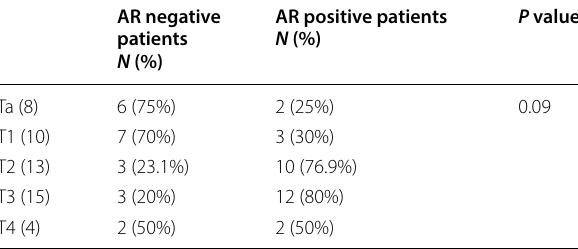
Table 1 Clinicopathological features of the studied urothelial bladder carcinoma patients